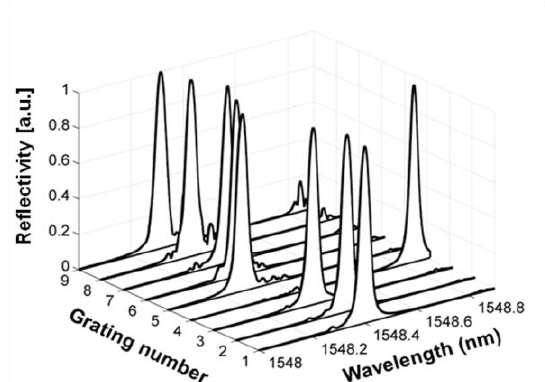
Figure 5. Overlapping FBG spectra measured by an FSI system that uses a light source consisting of a broadband ASE source and a tunable